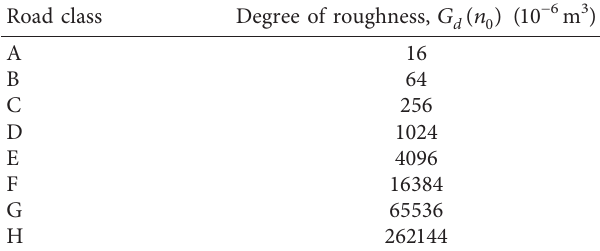
the beam has two DOFs, being the vertical displacement and the rotation.